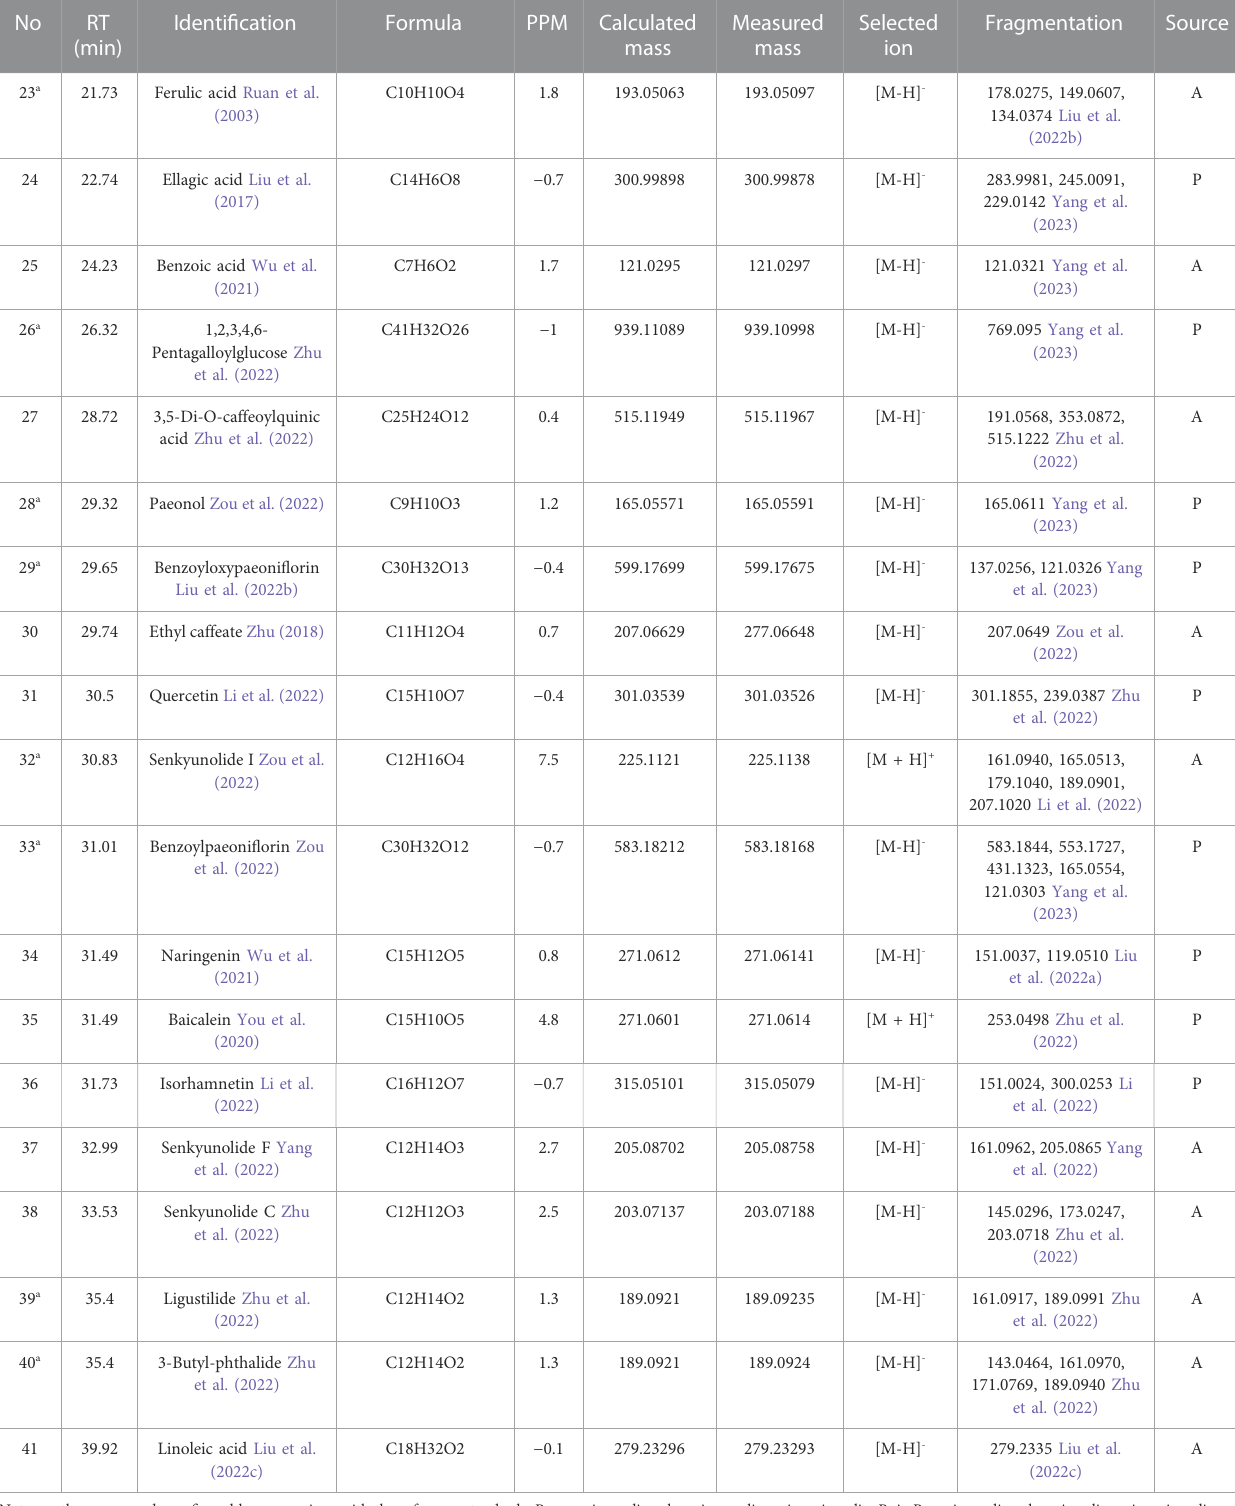
edges. The Degree value was used to screen the main components of P-A drug pair in the treatment of RA. The topological analysis yielded the key compounds